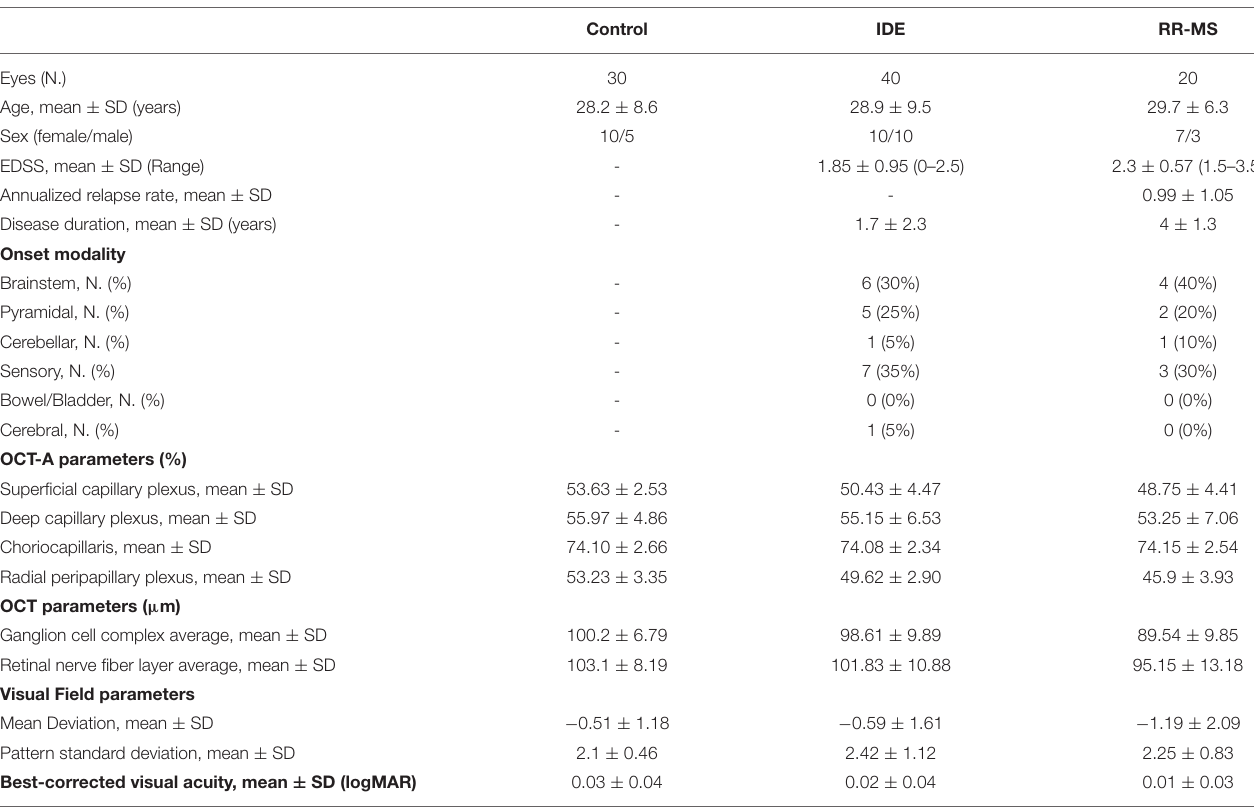
TABLE 1 | Demographic and clinical characteristics of IDE, RRMS patients and healthy controls.